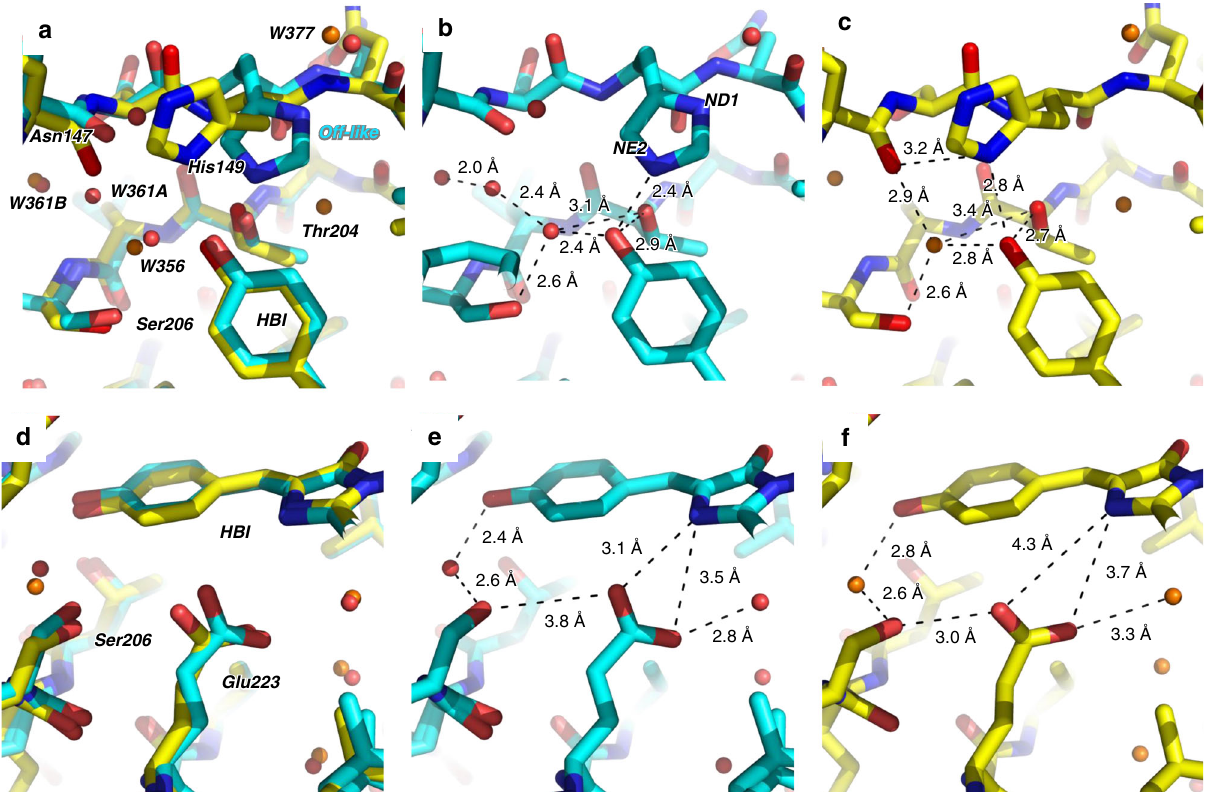
Fig. 6 Overlay of 10-ns intermediate-state and on-state structures. Overlay ( a , d ) of the chromophore region in the 10-ns intermediate structure (cyan, b , e ) and the on-state structure (yellow, c , f ) determined from SFX at room temperature (PDB entry code 5O89 27 ). The focus is on the phenol moiety of the chromophore, His149 and water W356 ( a – c ) and on the entire chromophore, Ser206 and Glu223 ( d – f ). Key distances are